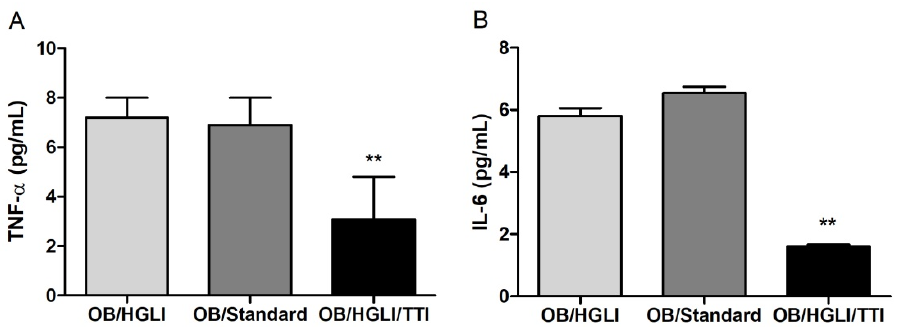
Figure 8. Plasma concentrations of inflammatory cytokines in Wistar rats with obesity induced by HGLI diet, after ten days of experiment. ( A ) Plasma TNF ‐α in animals in the groups: without treat ‐ ment (OB/HGLI), treated with a nutritionally adequate diet (standard diet Labina ® ) (OB/Standard) and treated with the trypsin inhibitor isolated from tamarind seeds (TTI) (OB/HGLI/TTI). ** p < 0.01 (one ‐ way ANOVA test with Tukey’s post ‐ hoc test); ( B ) plasma IL ‐ 6 in animals in the groups: with ‐ out treatment (OB/HGLI), treated with a nutritionally adequate diet (OB/Standard) and treated with the trypsin inhibitor isolated from tamarind seeds (TTI) (OB/HGLI /TTI). ** p < 0.01 (Kruskal–Wallis test with Dunn’s post ‐ hoc test). HGLI: high glycemic index and high glycemic load diet; IL ‐ 6: inter ‐ leukin 6; OB: obesity; TNF ‐α : tumor necrosis factor alpha. 3.3.3. TNF ‐α and IL ‐ 6 in the Small Intestine The results of the measurements of inflammatory cytokines in the animals’ small in ‐ testine homogenates did not show significant differences between the groups ( p = 0.902 and p = 0.944 for TNF ‐α and IL ‐ 6, respectively) (Figure 9).